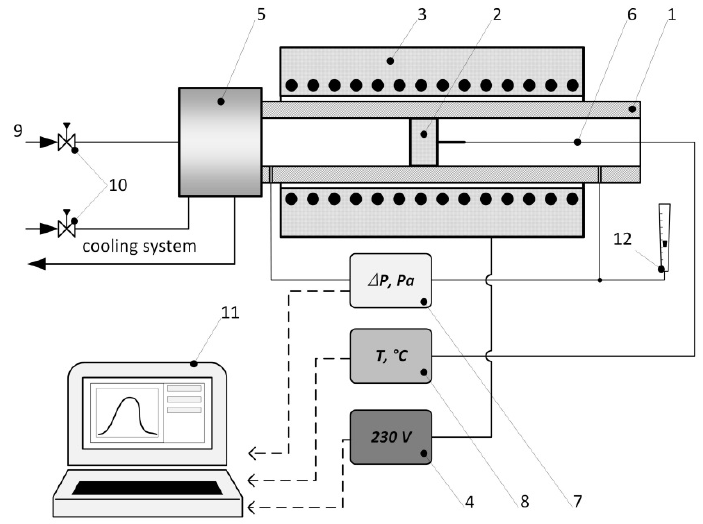
Figure 2. Pressure drop test stand (1—measuring tube, 2—sample, 3—furnace, 4—autotransformer, 5—radiator, 6—thermocouple, 7, 8—pressure gauge and thermometer, 9—compressed air, 10—fittings, 11—data acquisition and processing system, 12—rotameter).